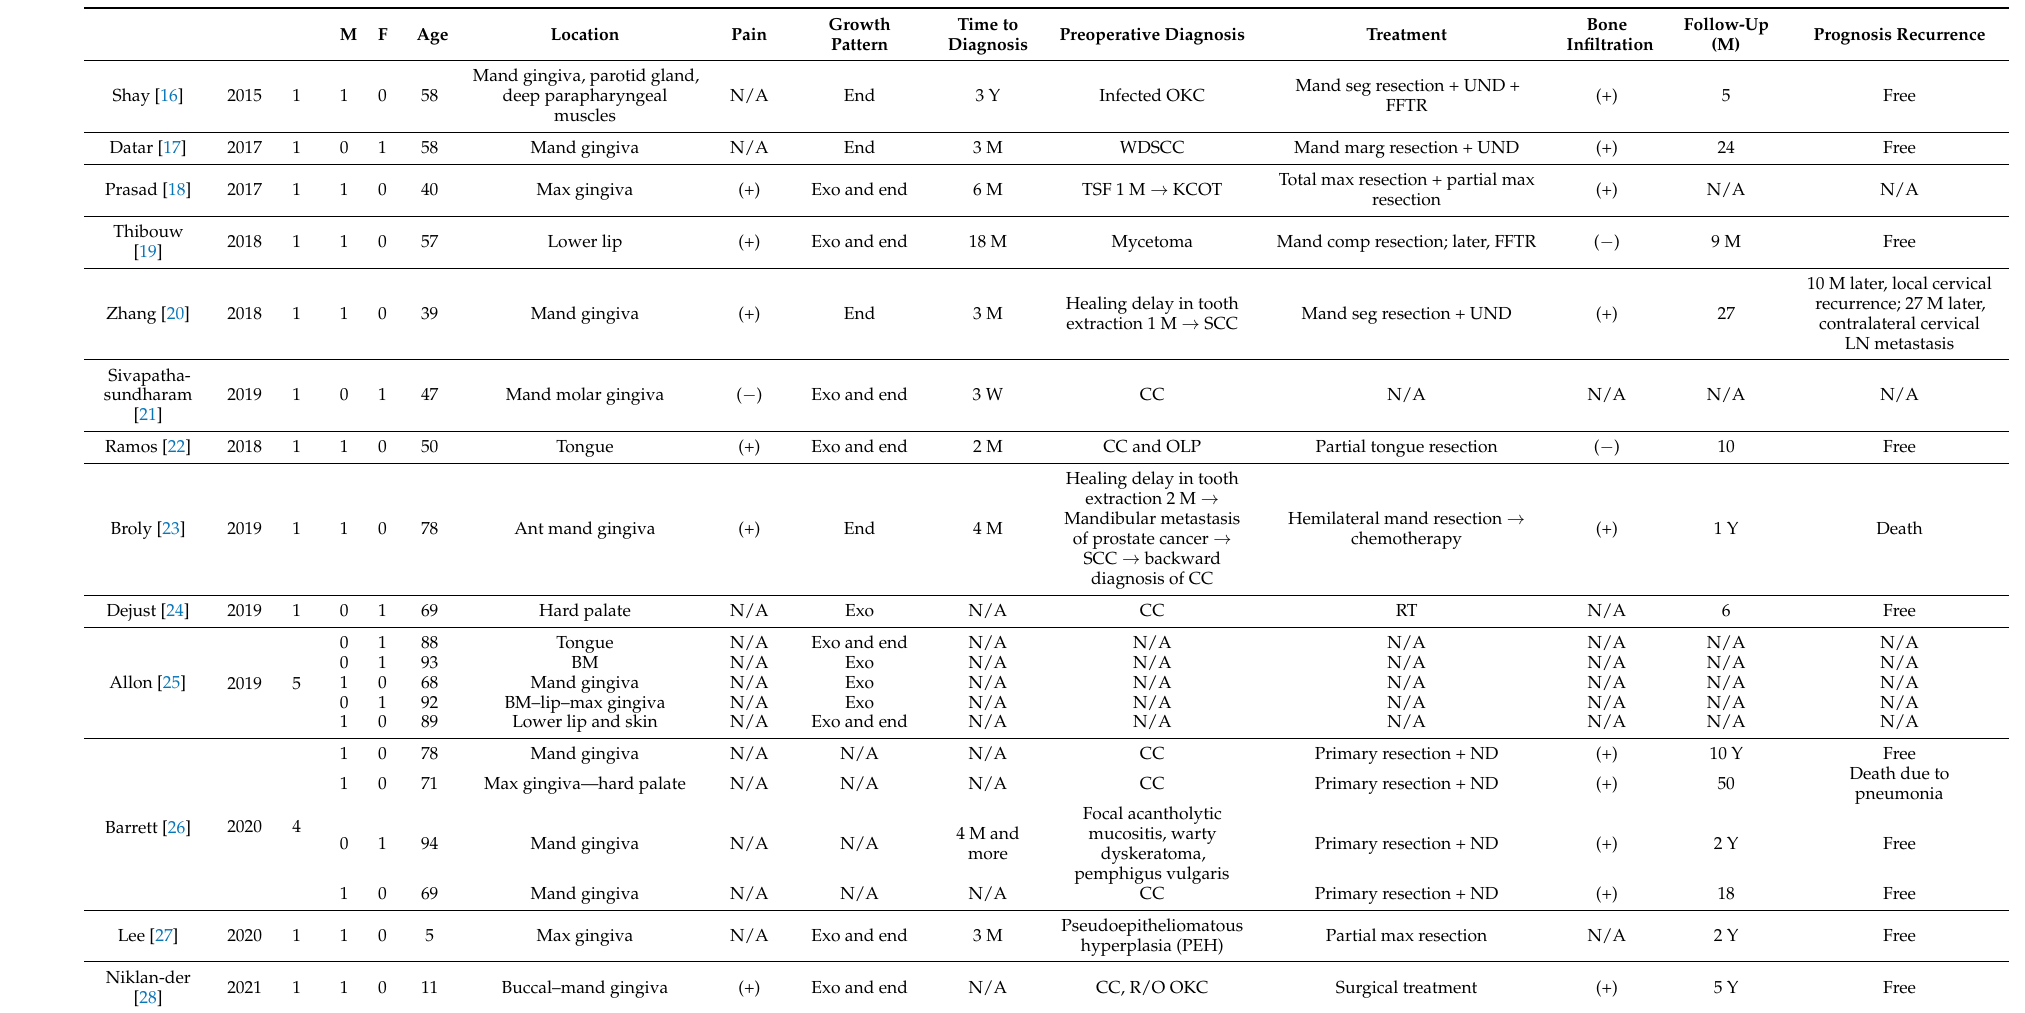
Pseudoepitheliomatous hyperplasia